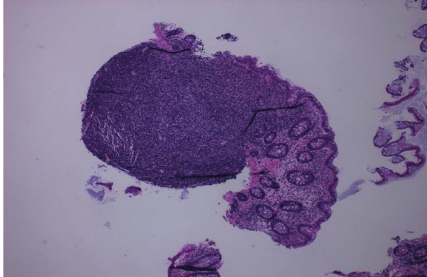
Figure 2: Hematoxylin and eosin stain showing lymphoid aggregate with normal colon mucosa.